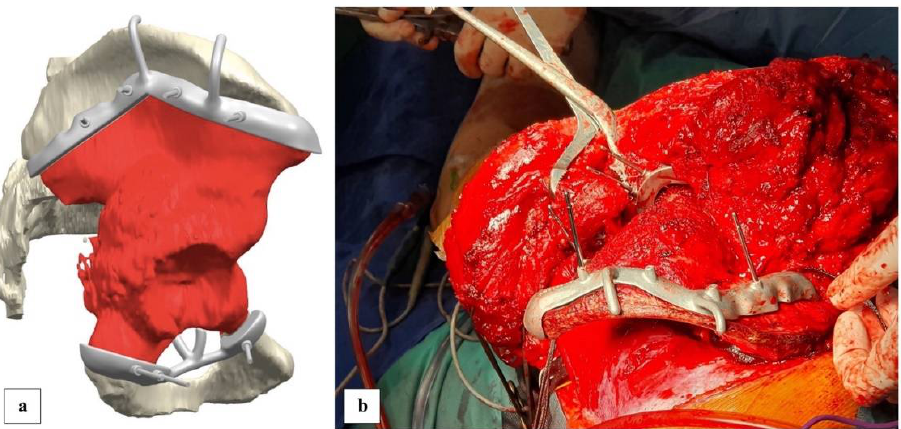
Figure 5. Preoperatory 3D setup of the cutting guides ( a ) were used to orientate the osteotomy of the bone tumour. Intraoperatory ( b ), the cutting guides were easily reproductible and this permitted us to obtain a negative margins resection of the bone lesion.